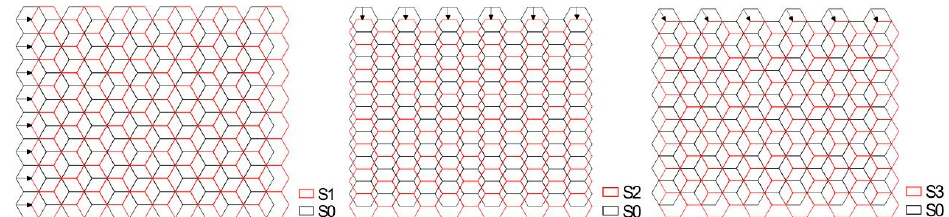
Figure 3. Grid Shifts. S 1 : Right shift, equal to the radius of the circumscribed circumference of the single hexagonal cell; S 2 : Down shift, equal to the apothem of the hexagonal cell; S 3 : Diagonal shift, equal to the radius of the circumscribed circumference of a single hexagonal cell.